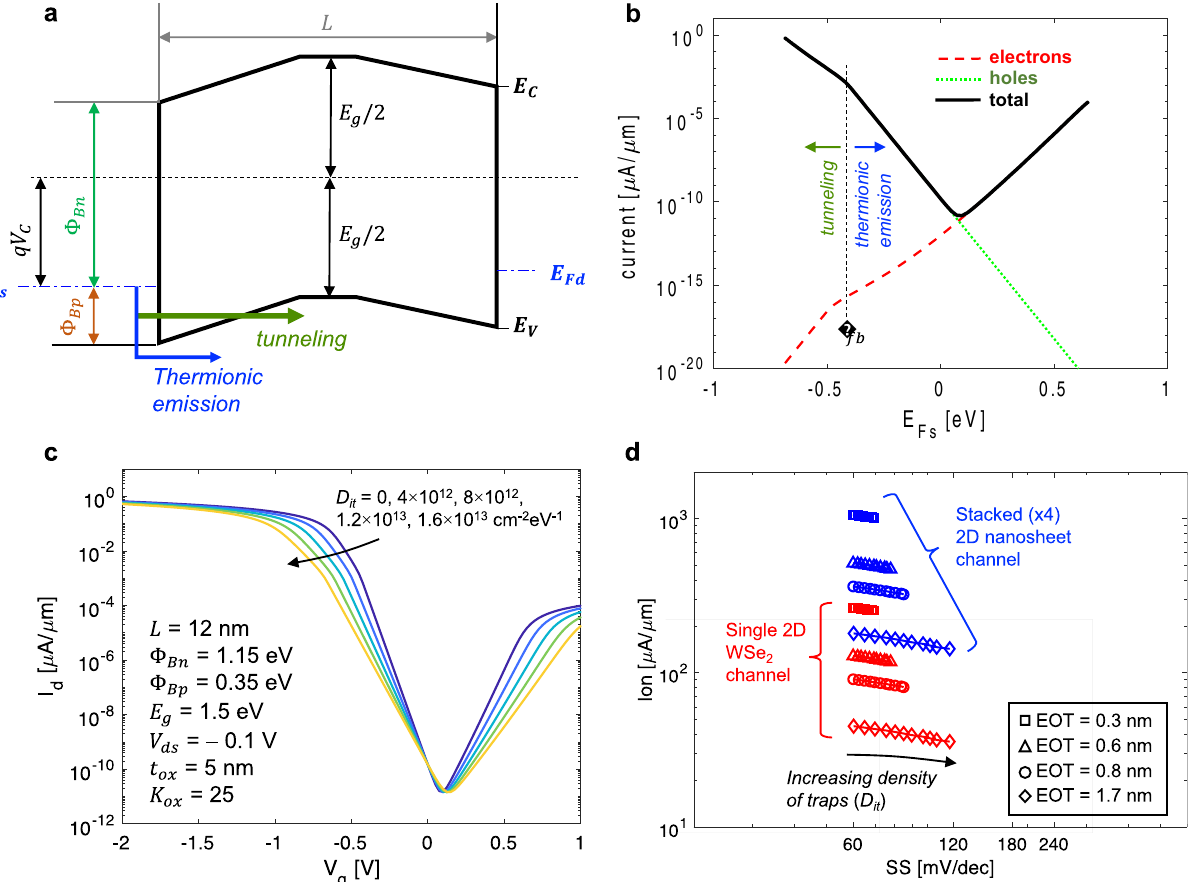
Figure 6. ( a ) Energy-band diagram for short-channel 2D WSe 2 PMOS FET with definitions of relevant energy levels and potentials used in calculation of ballistic FET I-V characteristics (see text). ( b ) Calculations of electron, hole, and total FET drain-to-source current as a function of the channel potential (i.e., relative position of the Fermi-level in the source to the semiconductor bands). Note that the zero energy reference is exactly at the middle of the bandgap. ( c ) Calculation of ballistic drain-to-source current as a function of V g for various levels of interface trap density (model parameters labelled in this plot). ( d ) Model predictions of I on vs SS in ballistic devices with different gate dielectrics (thickness and dielectric constant) as well as different levels of interface trap density. All values are for V g = – 2 V (sheet carrier density vary from ~ 10 12 to ~ 7 × 10 12 cm −2 ). Results in red are for single 2D WSe 2 channel, results in blue are for stacked 2D nanosheet channels (2D nanosheet FETs, see Fig. accounting for a metal–semiconductor work function difference and for the effects of surface states (interface traps) 20,21,53,54 . More details of the modeling approach are provided in the supplementary information. Figure 6b plots the current contribution from holes (green dotted line) in the valence band, electrons (red dashed line) in the conduction band, as well as the total current (solid black line) as a function of the channel potential. The labels in the plot show where the I–V characteristics transition from purely thermionic emission to where tun- neling starts to contribute (this happens when bands go flat at the metal/semiconductor junctions). Figure 6c plots the drain current vs gate voltage (I d –V g ) characteristics at room temperature for interface traps densities (D it ) of 0, 4 × 10 12 , 8 × 10 12 , 1.2 × 10 13 , and 1.6 × 10 13 cm −2 eV −1 . We note that these are typical trap densities for FETs with 2D channel materials 22 . Model parameters for these calculations are shown in Fig. 6c. As shown,